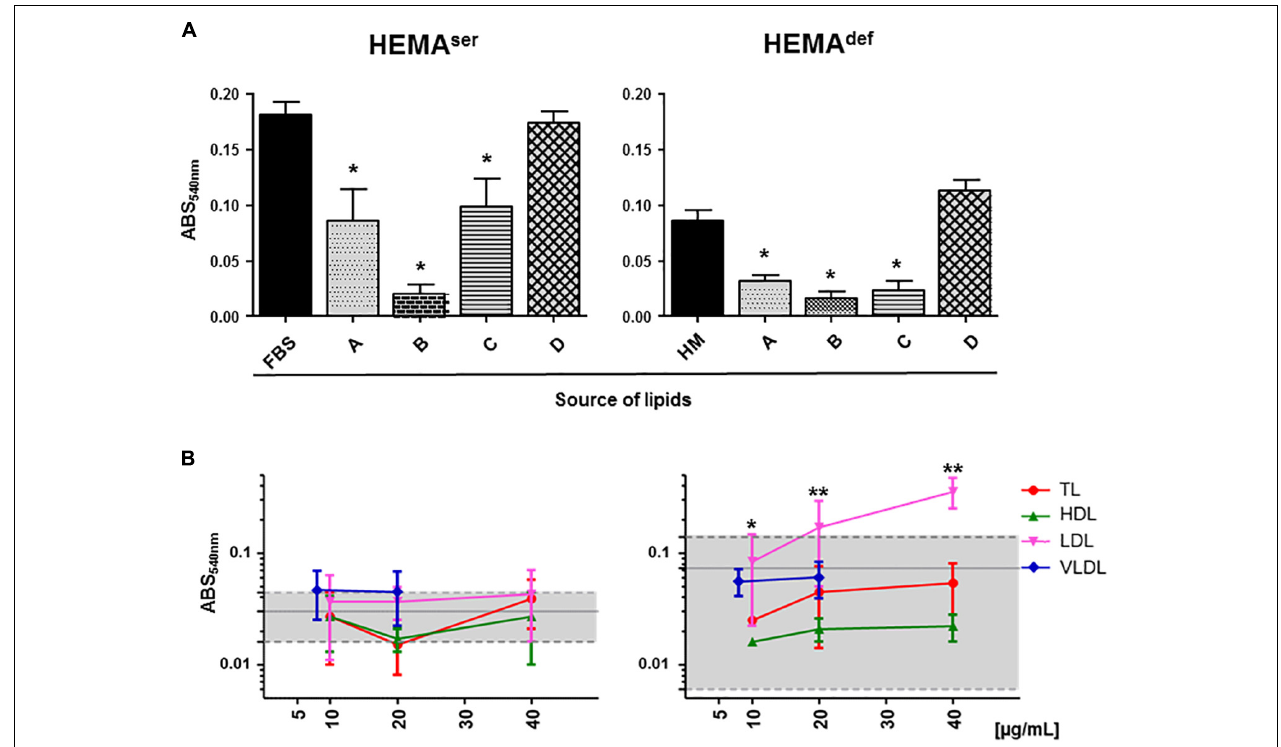
FIGURE 2 | Plasma lipoproteins increase short-term proliferation of human erythroblasts in HEMA def . (A) MTT proliferation assay of days 6 erythroblasts cultured for 4 days under HEMA ser (left panel) or HEMA def (right panel) conditions in the presence of commercially available lipid preparations. Source of lipids: (A) Lipids Cholesterol Rich from adult bovine serum (Cat. L-4646, Sigma-Aldrich); (B) Fatty Acid Supplement (Cat. F7050, Sigma-Aldrich); (C) Lipid Mixture (Cat. L-0288, Sigma-Aldrich) and (D) Chemically defined Lipid Concentrate (Cat. 11905, Gibco). In control cultures, the source of lipids was FBS (HEMA ser ) or home-made liposomes (HM, HEMA def ) designed to achieve maximal erythroblast amplification in chemically defined culture conditions (31) (see Materials and Methods for further details). Results are expressed as absorbance (ABS) at 540 nm and are presented as Mean ( ± SD) of three experiments performed in triplicate, each one with a different donor. Results statistically different from the corresponding controls ( p ≤ 0.01, by paired t test) are indicated by ∗ . (B) MTT proliferation assay of days 6 erythroblasts cultured for 4 days in the presence of increasing concentrations of lipoproteins purified from human plasma as described in Supplementary Figure S1 . Controls were represented either by FBS (HEMA ser ) or home-made liposomes (HEMA def ) and are indicated by the gray areas. Results are presented as Mean ( ± SD) of three experiments performed in triplicate. In HEMA def , results obtained with LDL are statistically different from the corresponding controls with p ≤ 0.05 ( ∗ ) at 10 µ g/mL and p ≤ 0.01 ( ∗∗ ) at 20 and 40 µ g/mL (by paired t